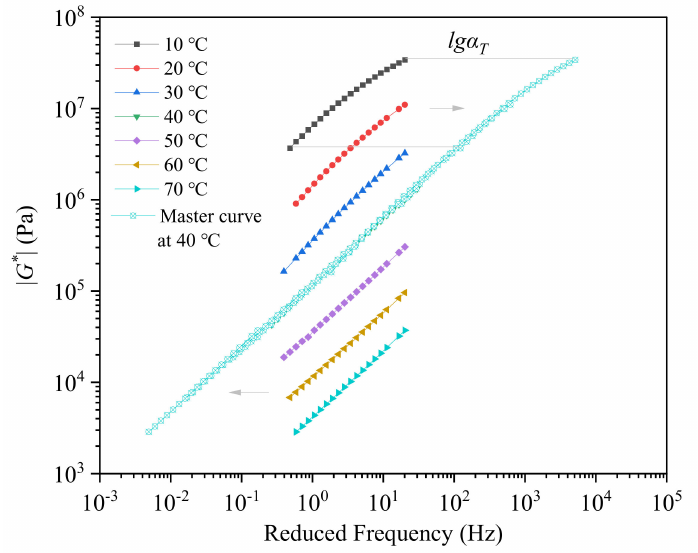
Figure 7. Shear modulus vs.